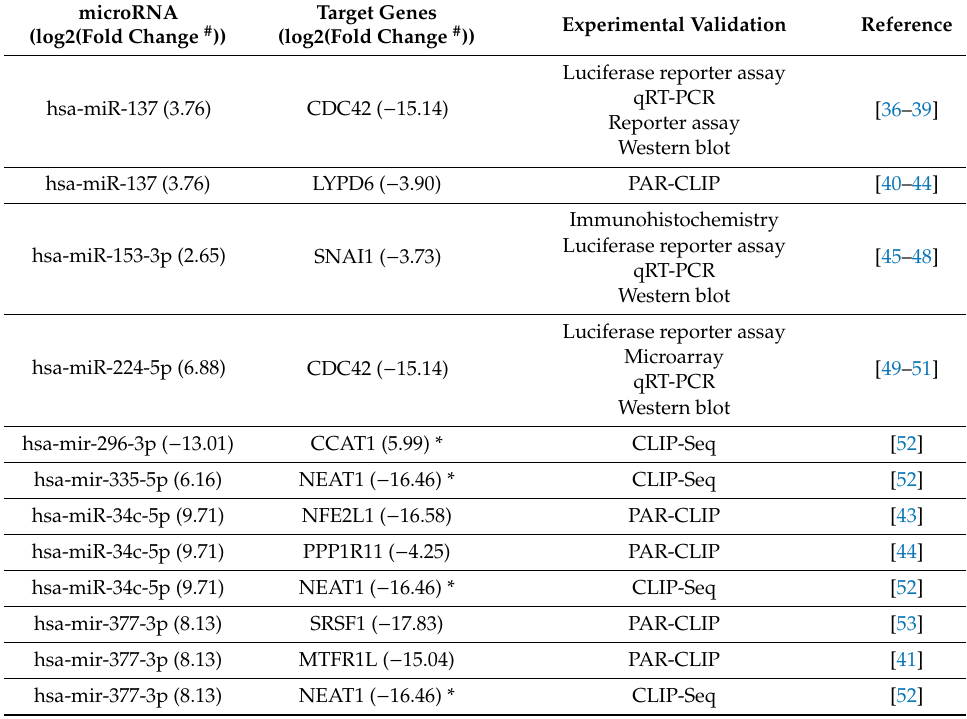
Table 4. The association between miRNA expression and survival